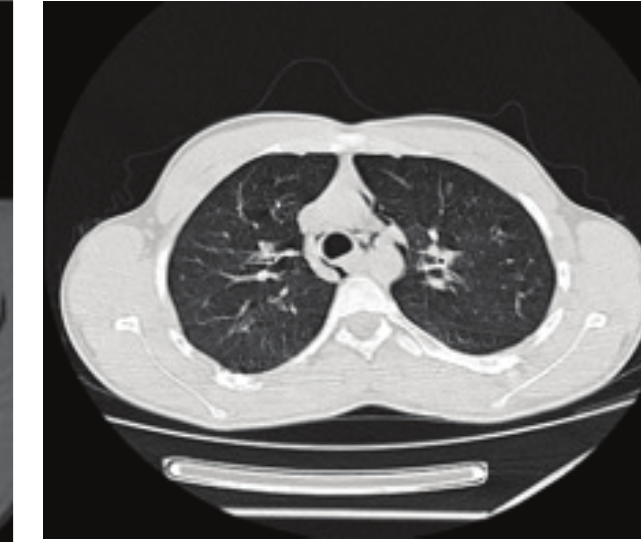
Figure 2 - Pneumomediastinum and diffuse intramuscular emphysema as shown in the computed tomography(CT) of the